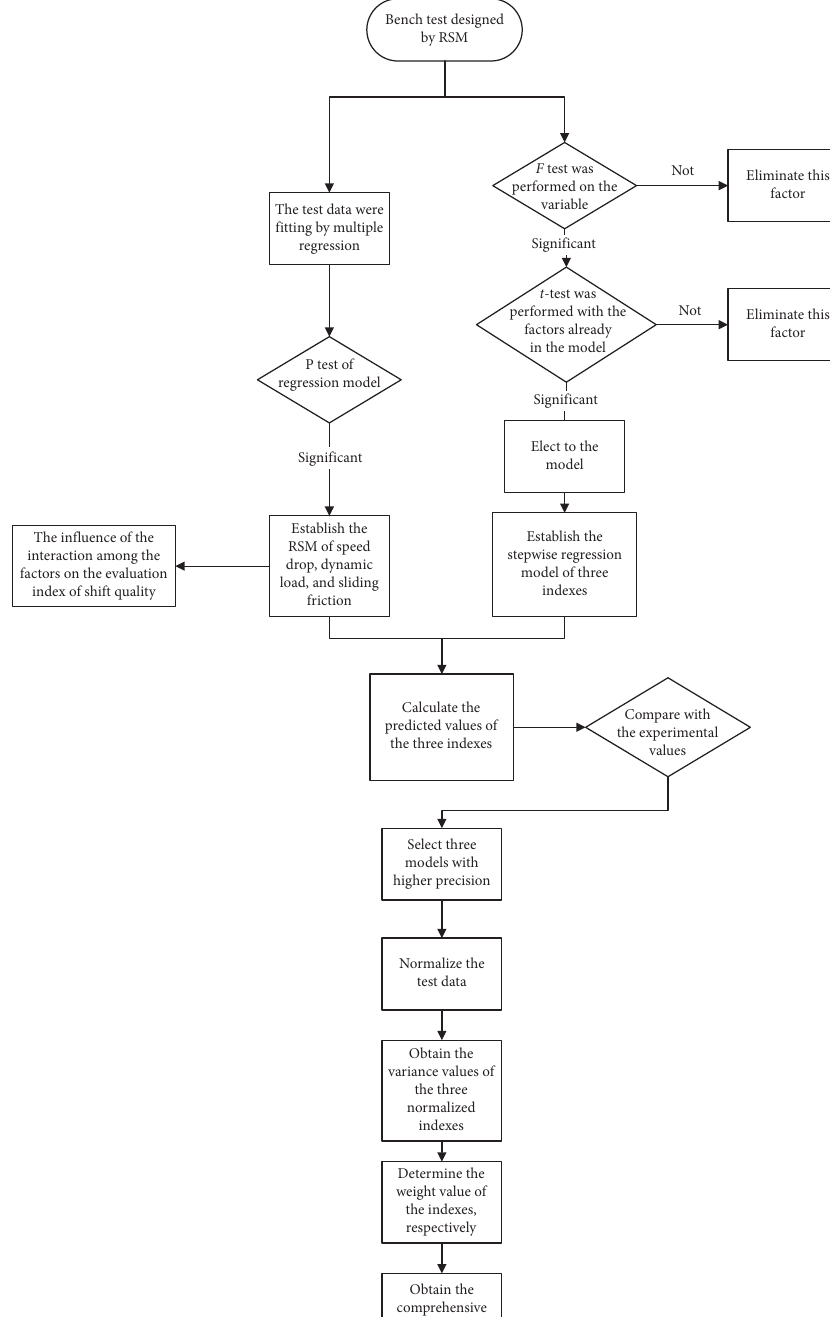
Figure 4: Research flowchart of comprehensive shift quality evaluation